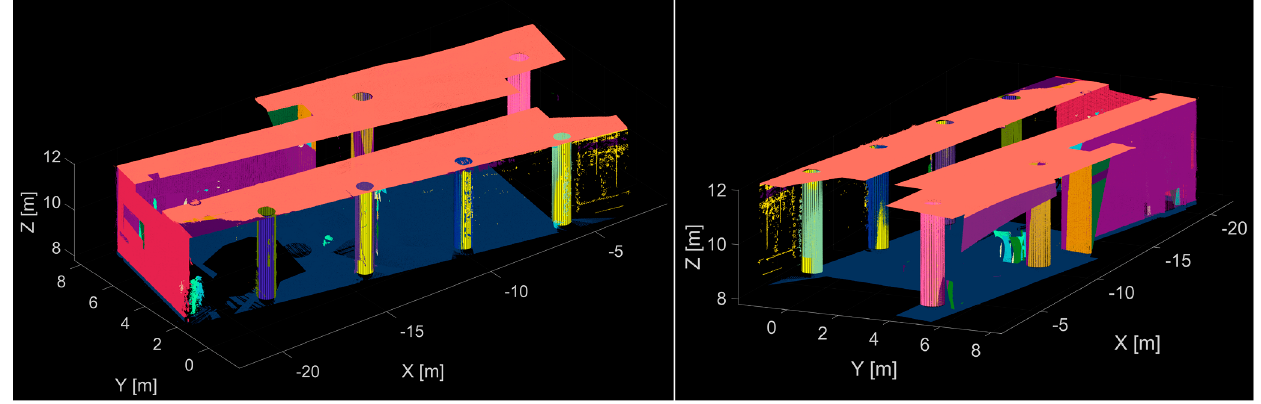
Figure 17. The cylinder segmentation results from the standard RANSAC algorithm. Table 5. Qualitative characteristics of cylinder segmentation. Point Cloud No.